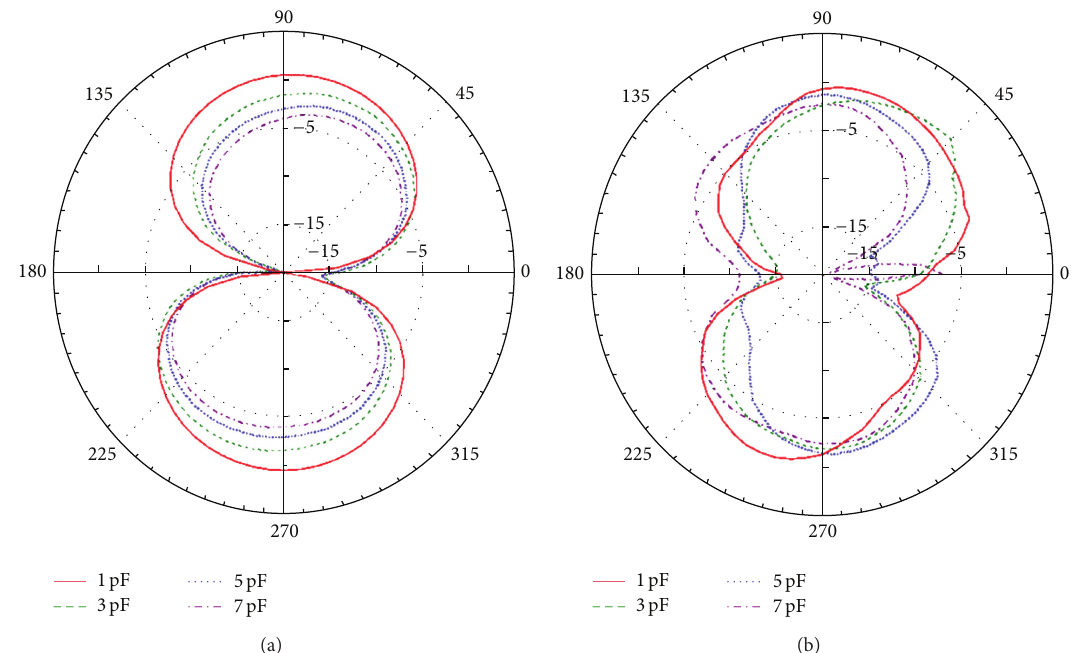
Figure 6: Radiation patterns on the XZ-plane: (a) simulated radiation patterns and (b) measured radiation patterns with different capacitances.